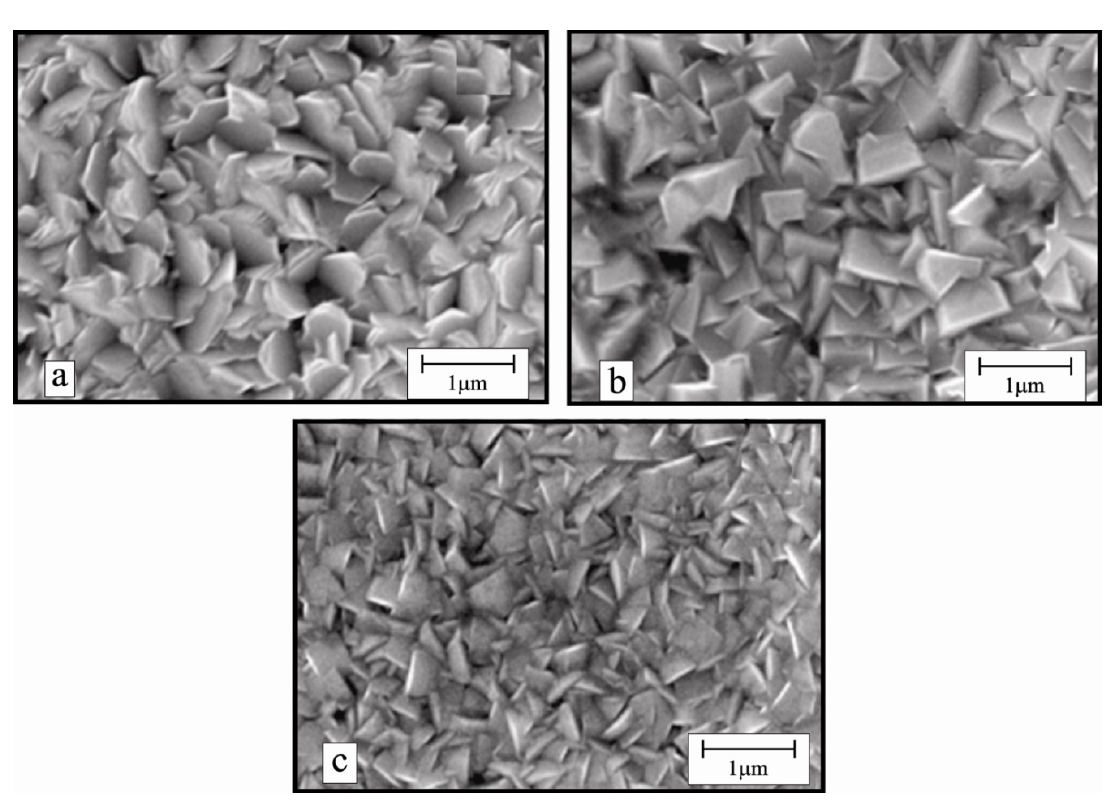
Figure 2. Typical SEM images of ZnO:In thin films prepared at ( a ) 1.5; ( b ) 3.0;